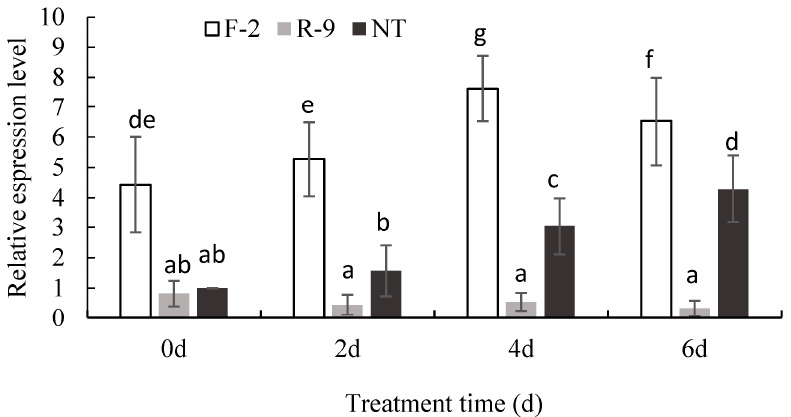
Figure 7. Effects of drought stress on gene expression in ScD27.2 F-2, ScD27.2R-9, and NT lines. Duncan’s new multiple range methods were used to analyze significant differences in gene expression at different time points after 6 days of stress treatment in 20% PEG-8000 MS medium. Different lowercase letters indicate significant differences at the 0.05 level. The error line represents the standard error ( n =